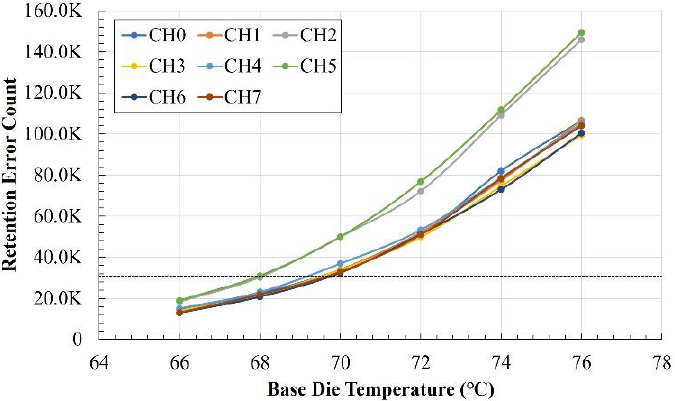
Figure 19. Retention errors in Pseudo channel 0 of all the channels with finer controlling temperatures varying from 66 ◦ C to 76 ◦ C at a fixed RCT of 2.045 s.